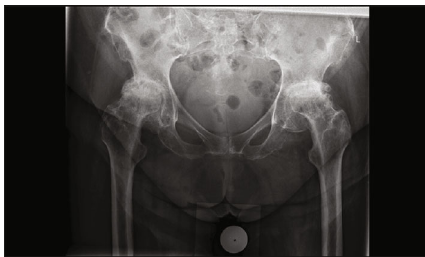
Figure 1: Preoperative anteroposterior X-ray of the pelvis.